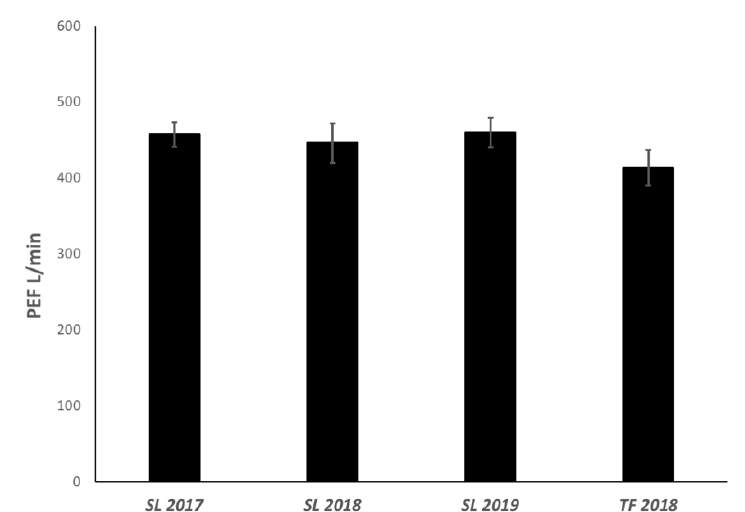
Figure 4. Peak expiratory flow values in the Seeley Lake and Thompson Falls cohorts. In the above graph the average peak expiratory flow (PEF) was calculated ( ± sem) for each year following the fires in 2017. Despite a slight decrease one year post exposure in 2018, there were no significant changes to the aggregate PEF values for the cohort and no di ff erence with the control cohort in Thompson